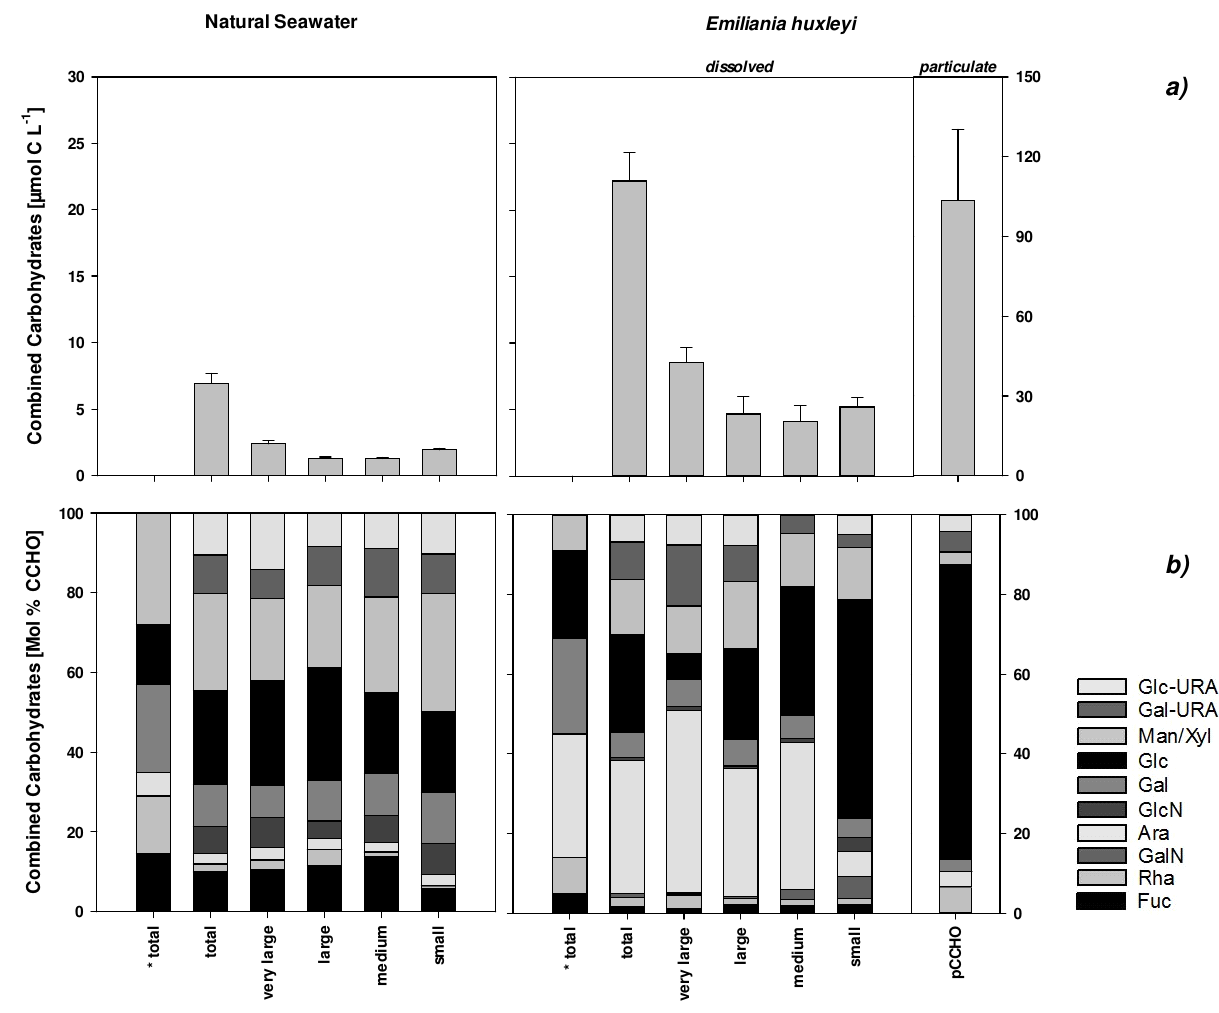
Figure 3. Concentration [µmol CL − 1 ] (a) and composition [mol% CCHO] (b) of high-molecular-weight ( > 1kDa) dissolved combined carbohydrates (HMW- d CCHO). Data are shown for natural seawater used to prepare the experimental culture media (left panels) and com- position in natural seawater enriched with freshly produced HMW- d CCHO derived from E. huxleyi (rights panels) grown in chemostats. Due to the strong similarity between the present-day and high-CO 2 treatment, both were treated as replicates. Stacked bars show the average of replicate samplings (samplings 3–5, n = 6) performed during the steady-state period of the experiment. Data for HMW- d CCHO for natural seawater and E. huxleyi taken from Aluwihare (1999) for comparison. Here, only neutral carbohydrates are included, since amino and acidic HMW- d CCHO were not